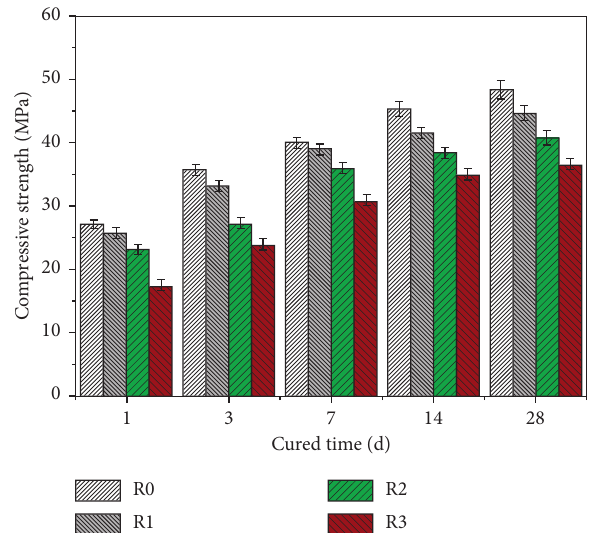
Figure 3: Compressive strength of resin modified cement slurry.